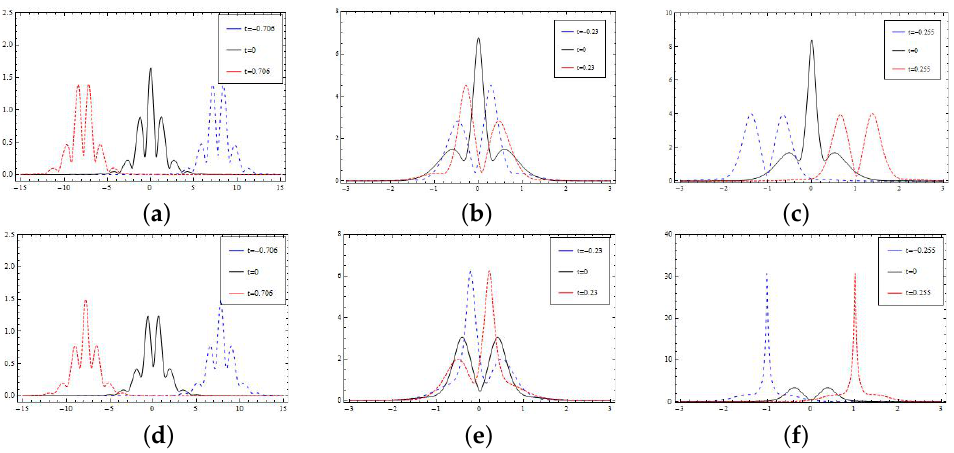
Figure 4. Breather solutions for the nonlocal gSS Equation (5): ( a – c ) the focusing case with (cid:101) = 1, a = − 1, b = 1 , ( d – e ) the defocusing case with (cid:101) = 1, a = 1, b = 1 5 λ 1 = 1 + i ; ( b , e ) KM-breather solution with λ 1 = 1 + 2